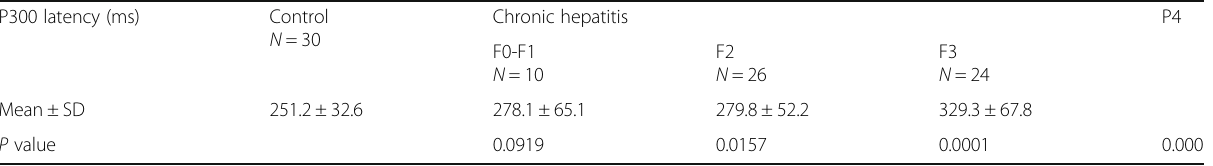
Table 5 Comparison of the P300-evoked potential latency between the studied groups P300 latency (ms)